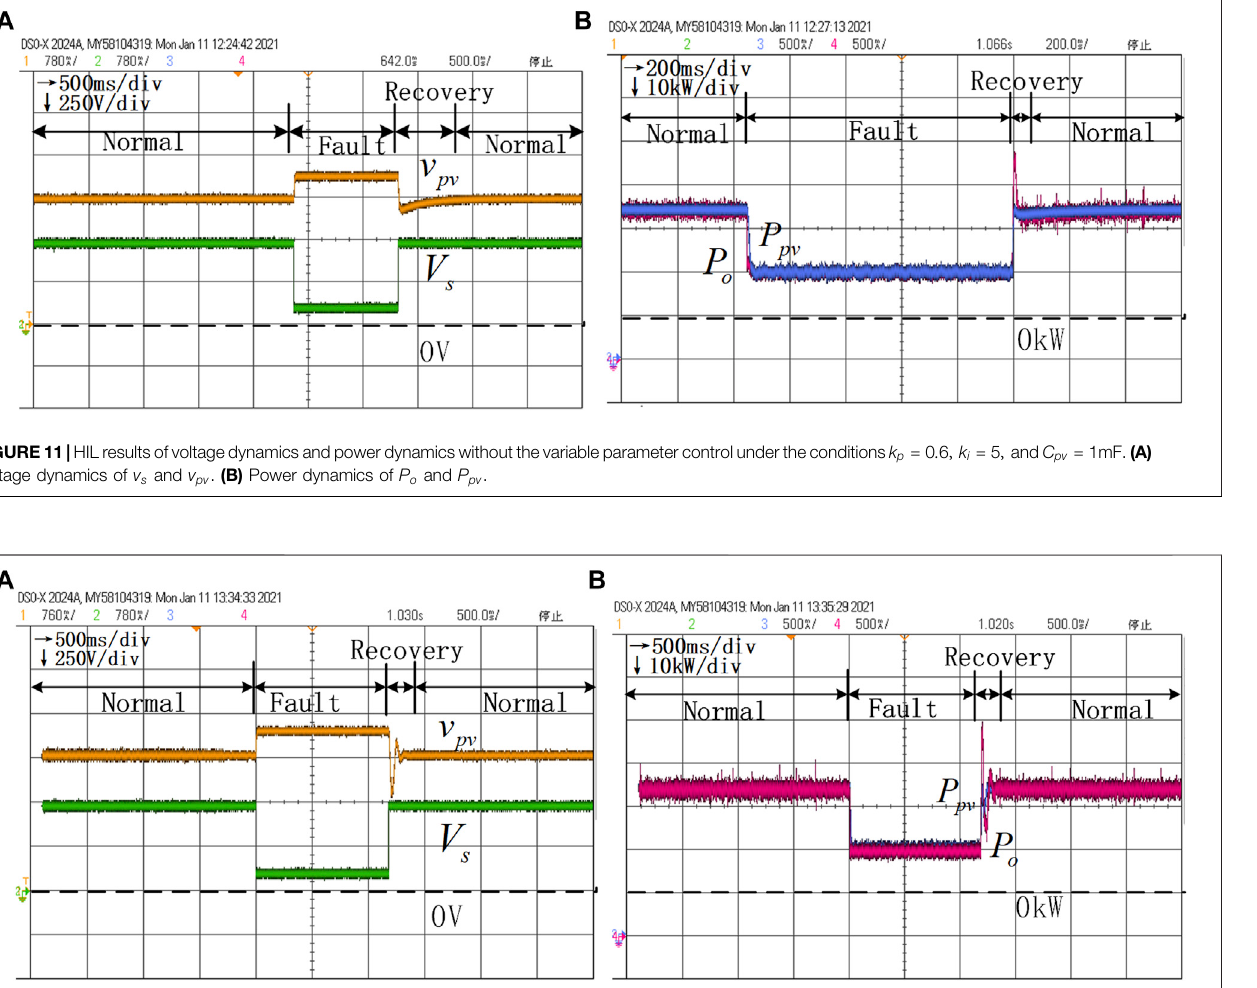
FIGURE 12 | HIL results of voltage dynamics and power dynamics without the variable parameter control under the conditions k p (cid:1) 0 . 1 , k i (cid:1) 40 , and C pv (cid:1) 1mF. (A) Voltage dynamics of v s and v pv . (B) Power dynamics of P o and P pv